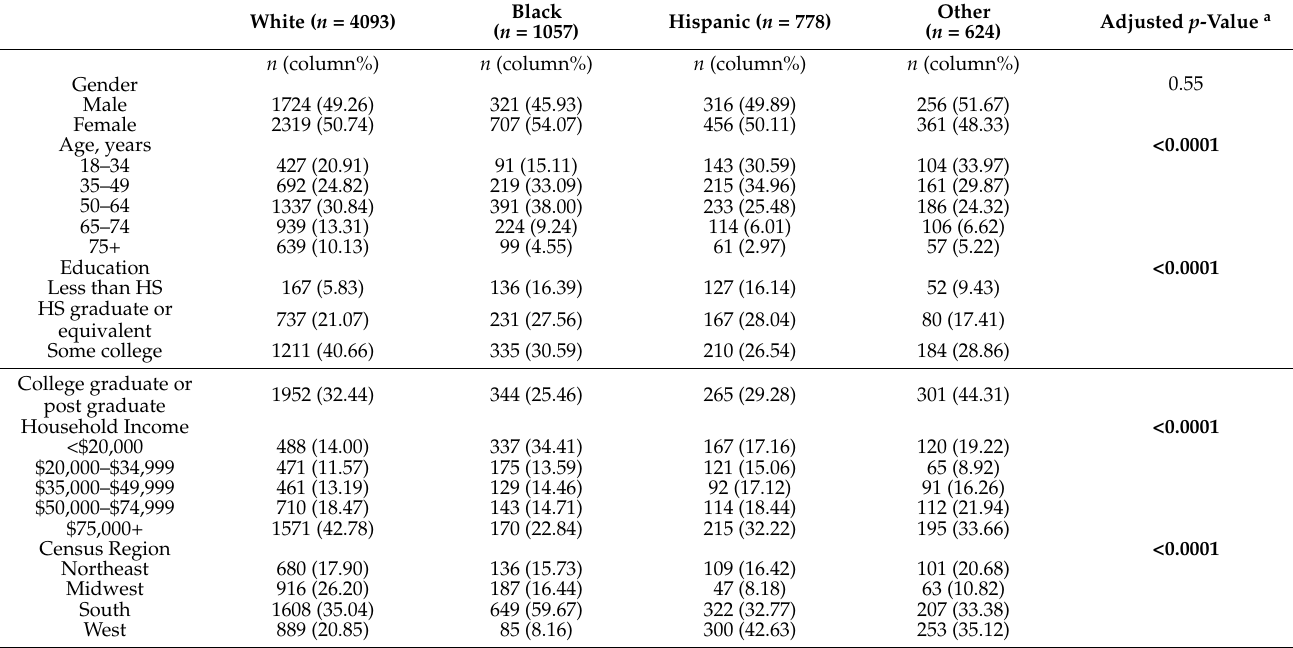
Table 1. Weighted respondent characteristics by racial/ethnic group, HINTS 5 Cycle 1 and 2, 2017–2018 ( n =